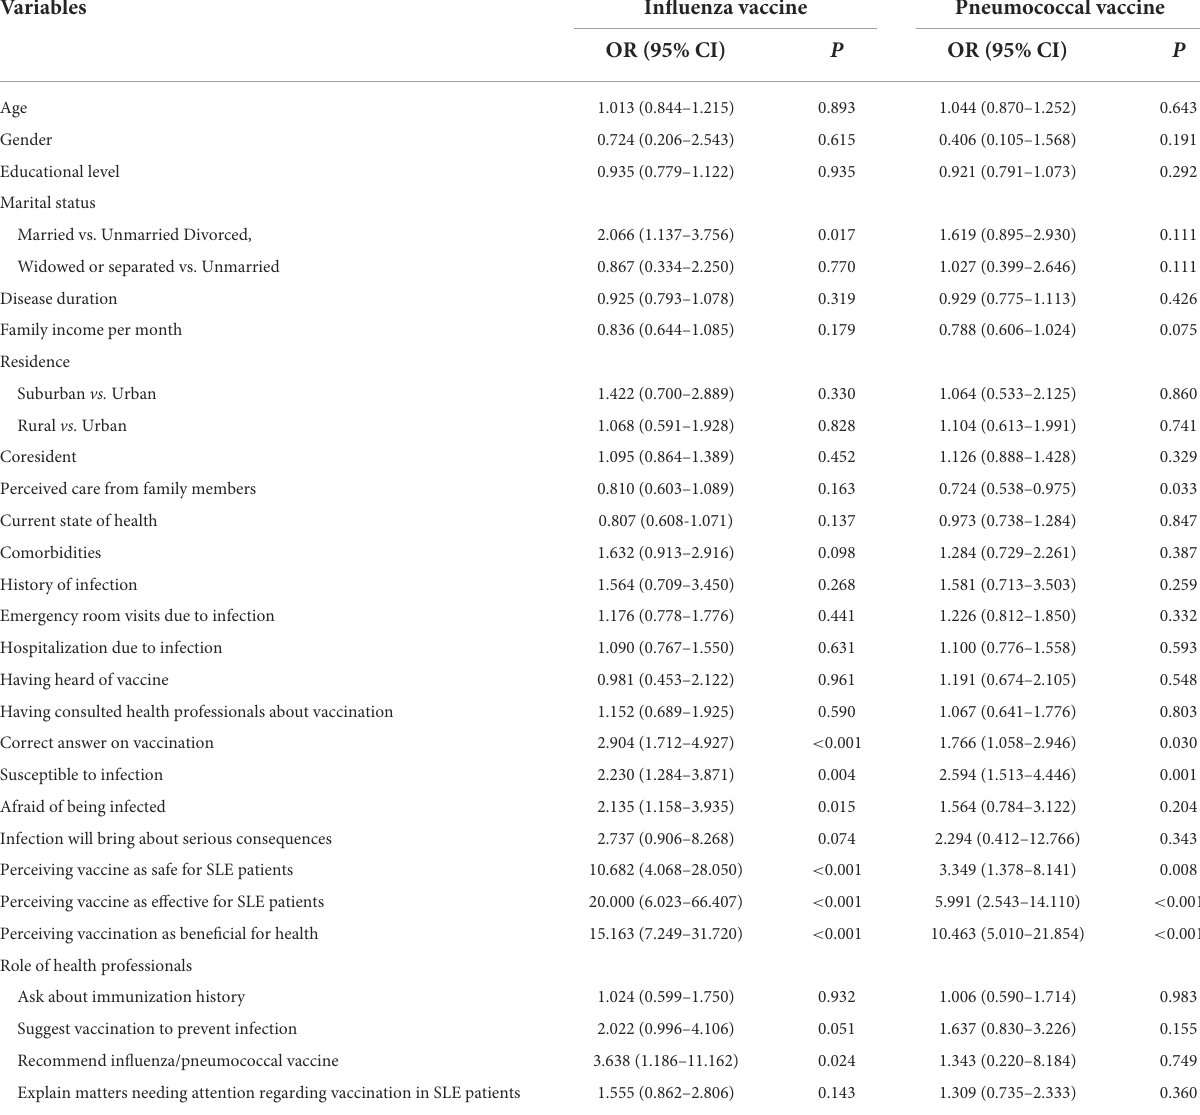
TABLE 4 Univariate analysis of factors associated with willingness to get influenza and pneumococcal vaccination among SLE